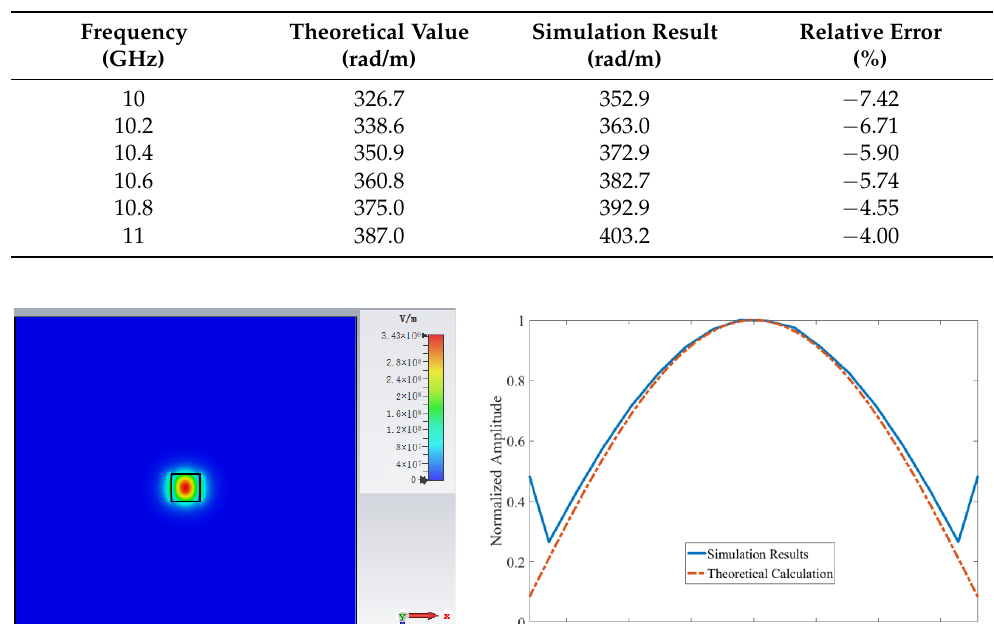
Table 1. Theoretical and simulated real parts of longitudinal phase constants for guide mode.